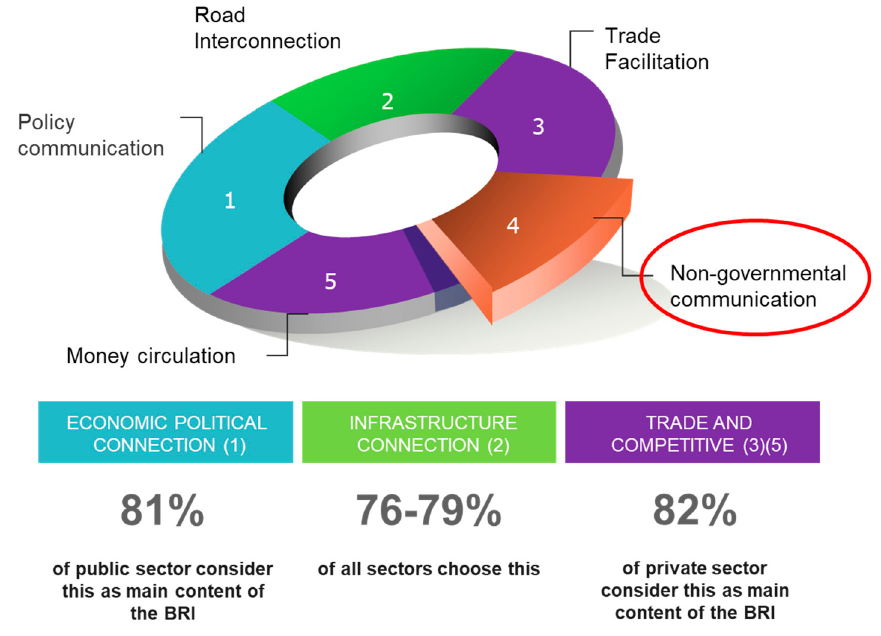
Figure 3. Respondents’ understanding about the BRI (Source: Authors’ analysis).